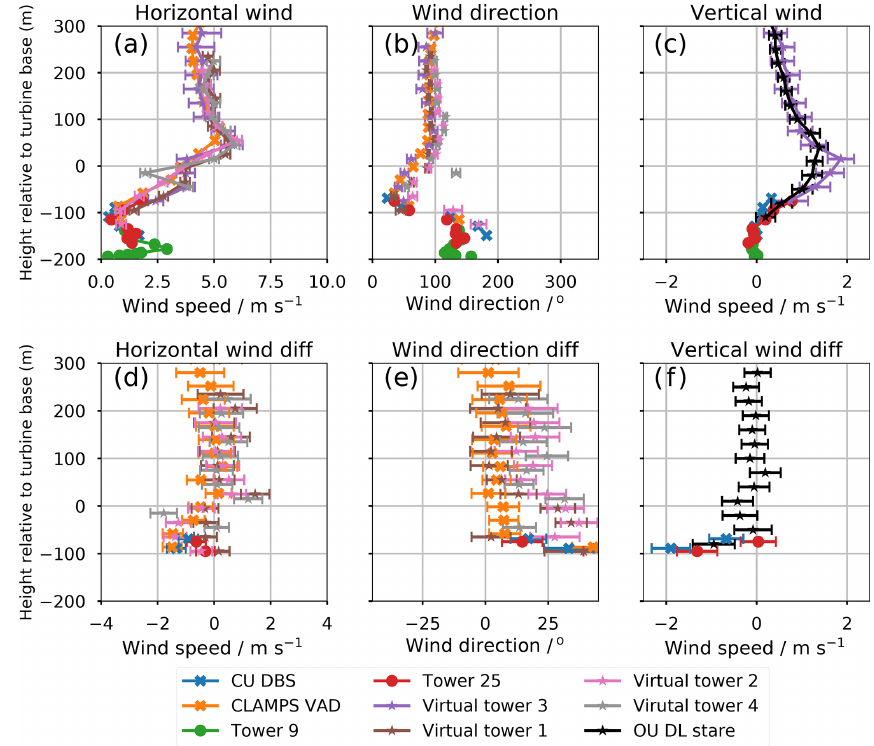
Figure 9. Similar to Fig. 6, only with VT1 (brown) and VT4 (gray) included. Profiles are from 8 May at 00:32UTC. In general, the methods agree well above the ridge (generally greater than 100m), but results begin to get noisy 100m below ridge height. For the sake of readability, only every third point has been plotted for the virtual